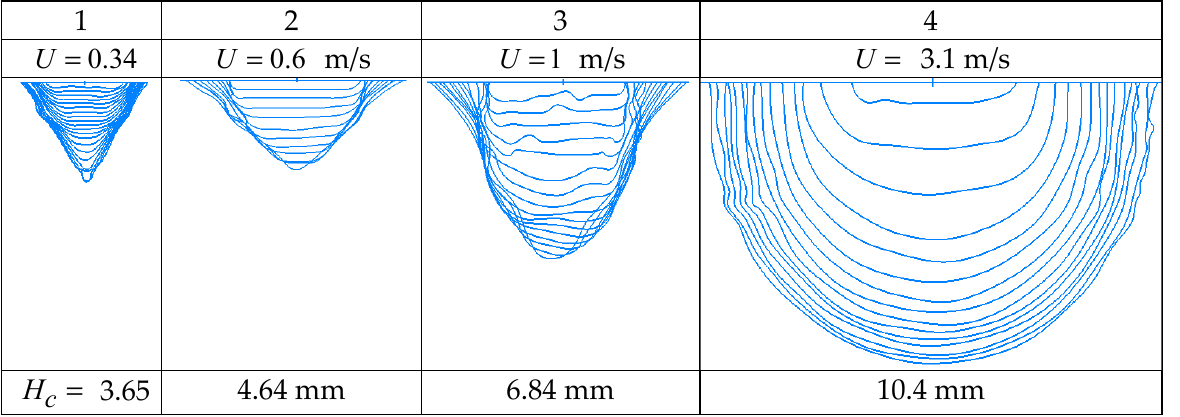
Figure 14. Sequences of external contours of cavities in different modes of drop coalescence: the second line shows the contact velocities of the drop, the last line shows the maximum depth of the cavity. Table 2. The position of the regular protrusion on the left side wall of the cavity. U ,